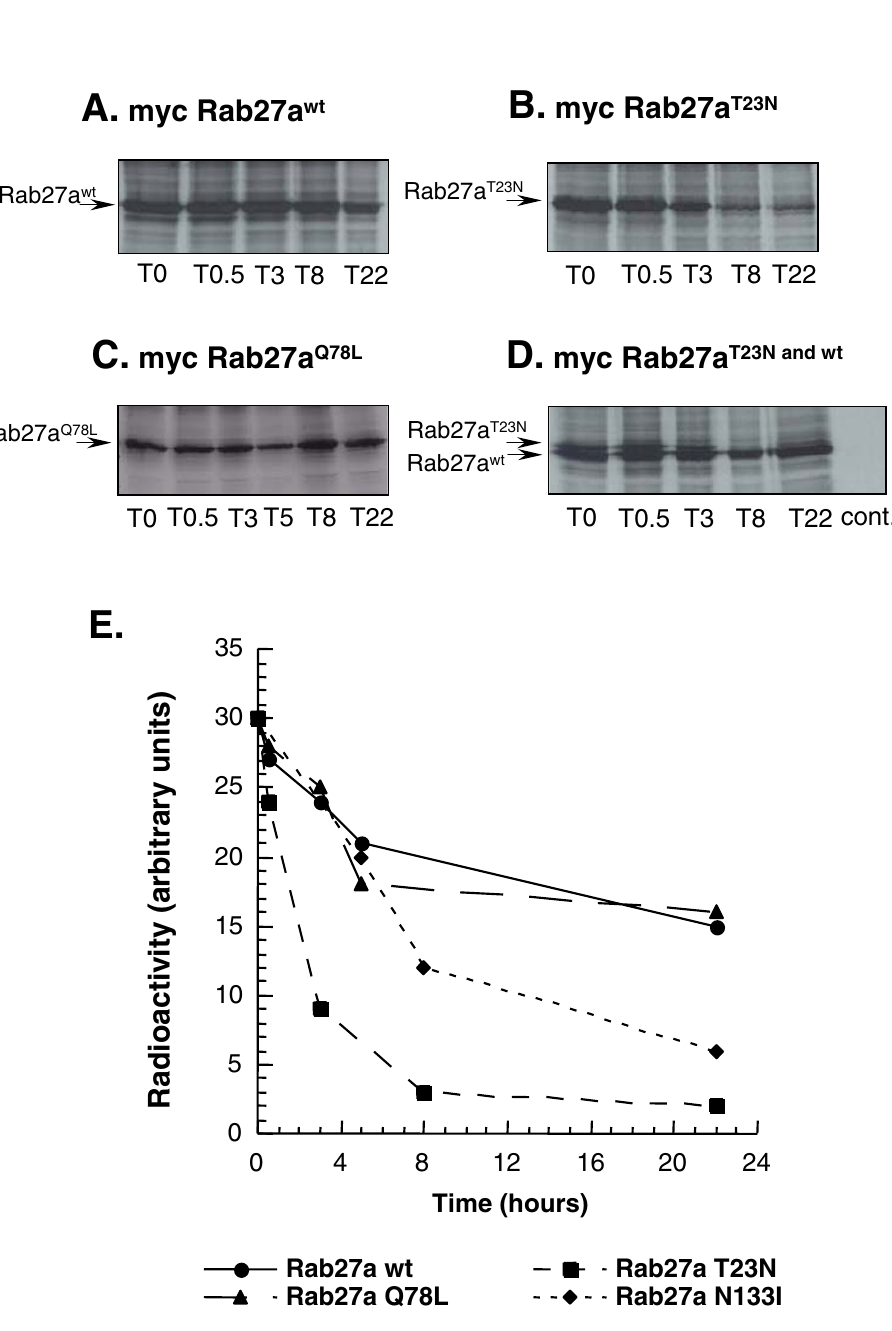
Figure 5 Half-lives of wild-type, Rab27a T23N , Rab27a Q78L and Rab27a N133I mutant proteins. COS-7 cells transfected with either pCAGGS myc-Rab27a WT (A), pCAGGS myc-Rab27a T23N (B), pCAGGS myc-Rab27a Q78L (C), or co-transfected with pCAGGS myc-Rab27a WT and pCAGGS myc-Rab27a T23N (D) were labelled with [ 35 S]methionine/cysteine for 2 h and subsequently chased in Dulbecco's modified Eagle's medium for the indicated times. Rab27a protein was immunoprecipitated from cell extracts, collected with protein G-Sepharose beads, separated on a 12% SDS-polyacrylamide gel and autoradiographed as described under "Methods". (Panel E) Quantification of radiolabelled samples obtained